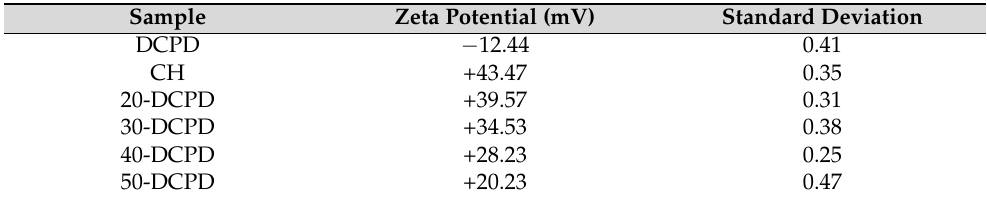
Table 4. Zeta potential measurements of the unloaded and Dicalcium Phosphate Dihydrate (DCPD) loaded freeze-dried chitosan scaffold